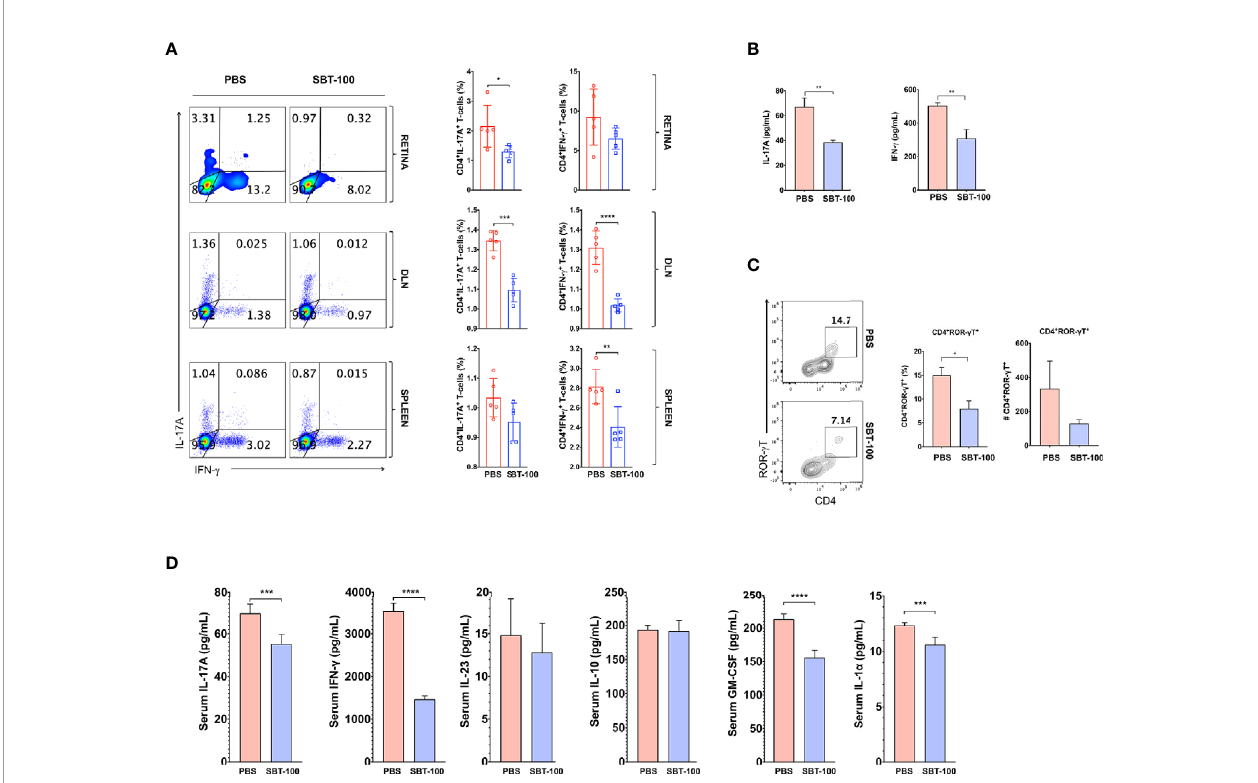
FIGURE 5 | SBT-100 inhibits secretion of proin fl ammatory cytokines by pathogenic T cells. Following the adoptive transfer of activated IRBP-speci fi c cells from PBS- treated or SBT-100 treated mice with EAU to naive C57/BL6J mice, we analyzed expression of Th1 and Th17 signature genes by intracellular cytokine staining assay or ELISA. Quadrants in (A) indicate percentage of CD4 + T cells expressing IFN- g or IL-17 in the retina, DLN, or spleen and Th1 or Th17 cells. (B) Following the adoptive transfer of activated IRBP-speci fi c T cells from PBS-treated or SBT-treated mice with EAU to naive C57/BL6J mice, CD4 + T cells from the lymph nodes and spleen of the recipient mice were restimulated in vitro with IRBP 651-670 and IL-17A and IFN- g secreted in Day 3 culture supernatant was detected by ELISA. (C) Quadrants indicate the percentage of CD4 + T cells expressing ROR- g T in the retina. (D) The levels of IL-17A, IFN- g , GM-CSF, IL-1 a , and IL-10 in the blood were detected by multiplex ELISA. Data represent at least two independent experiments and presented as mean ± SEM. (* p < 0.05; ** p < 0.01; *** p < 0.001; **** p <